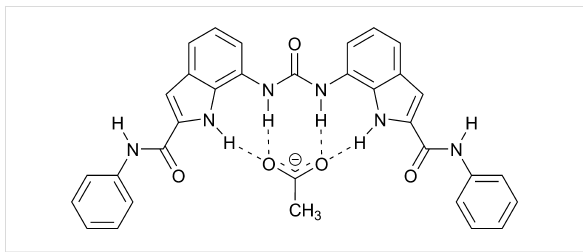
Figure 9: Conformational preferences and proposed binding mode for the 3 ·AcO − 1:1 complex.